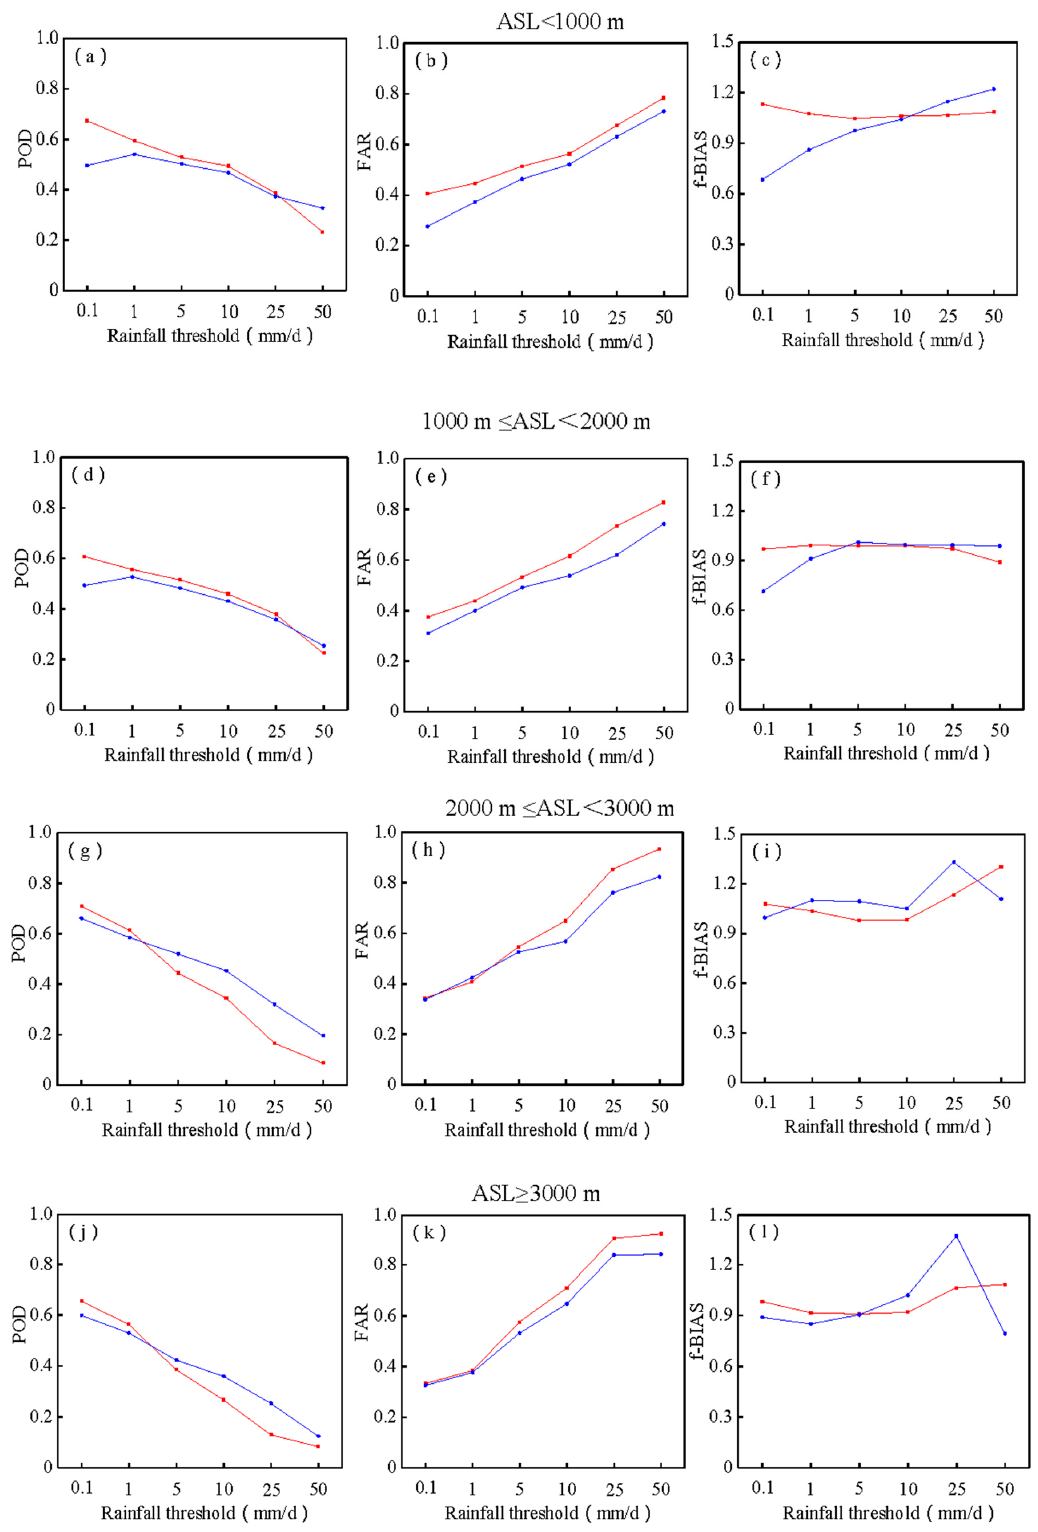
Figure 8. Contingency metrics of POD , FAR and f-BIAS at di ff erent altitudes. ( a – c ): ASL < 1000 m; ( d – f ): 1000 m ≤ ASL < 2000 m; ( g – i ): 2000 m ≤ ASL < 3000 m; ( j – l ): ASL ≥ 3000 m).